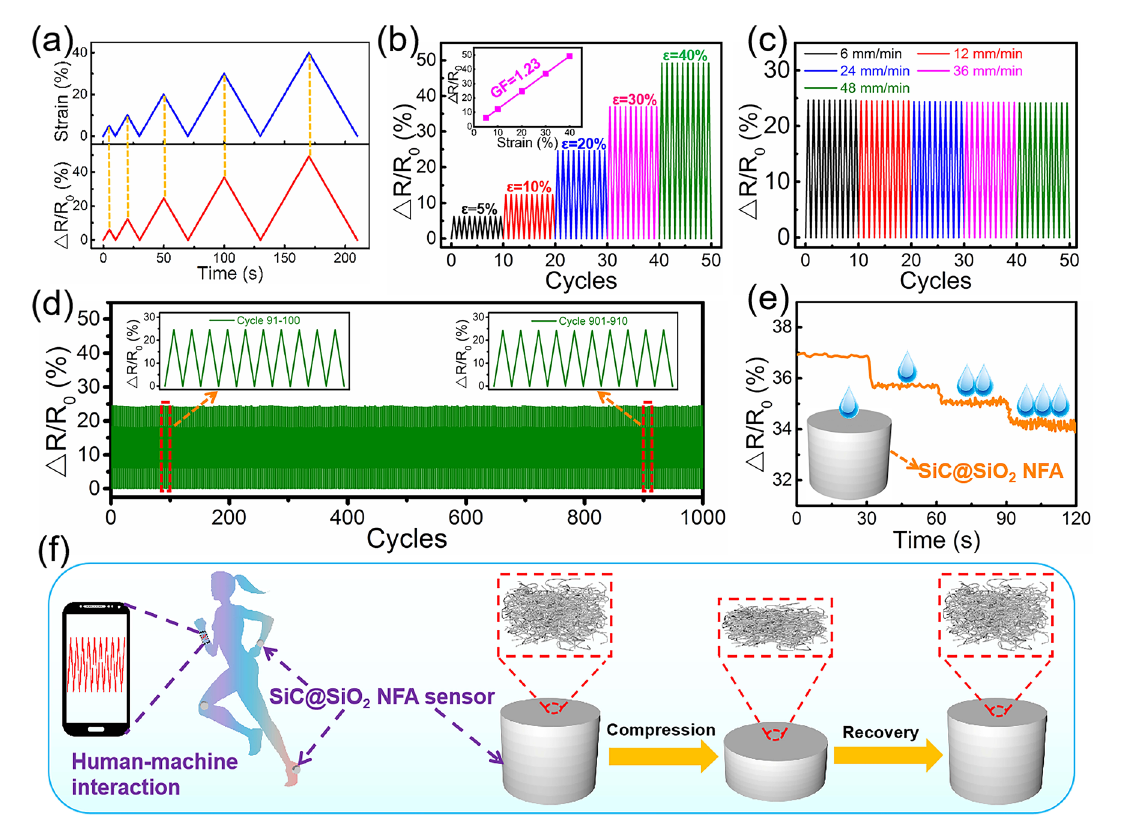
Fig. 5 Strain- and pressure-sensing behaviors of the SiC@SiO 2 NFA. a Δ R / R 0 for the SiC@SiO 2 NFA with the strain from 5 to 40% at a com- pression rate of 6 mm min −1 . b Real-time Δ R / R 0 cycling test at different compression strains under a compression speed of 6 mm/min; Δ R / R 0 varies linearly with strain (inset b , GF = 1.23). c Δ R / R 0 for the SiC@SiO 2 NFA under various compression rates with a compression strain of 30%. d Stability testing of the piezoresistive behavior of SiC@SiO 2 NFA with a 30% compressive strain, 6 mm min −1 compression rate, and 1000 cycles (inset shows the magnified curves). e Real-time ΔR/R 0 response in the presence of drops of NaCl aqueous solution (inset depicts the corresponding schematic diagram for the NaCl aqueous solution drop tests). f Applications of the SiC@SiO 2 NFA pressure sensor to detect body activities and tiny